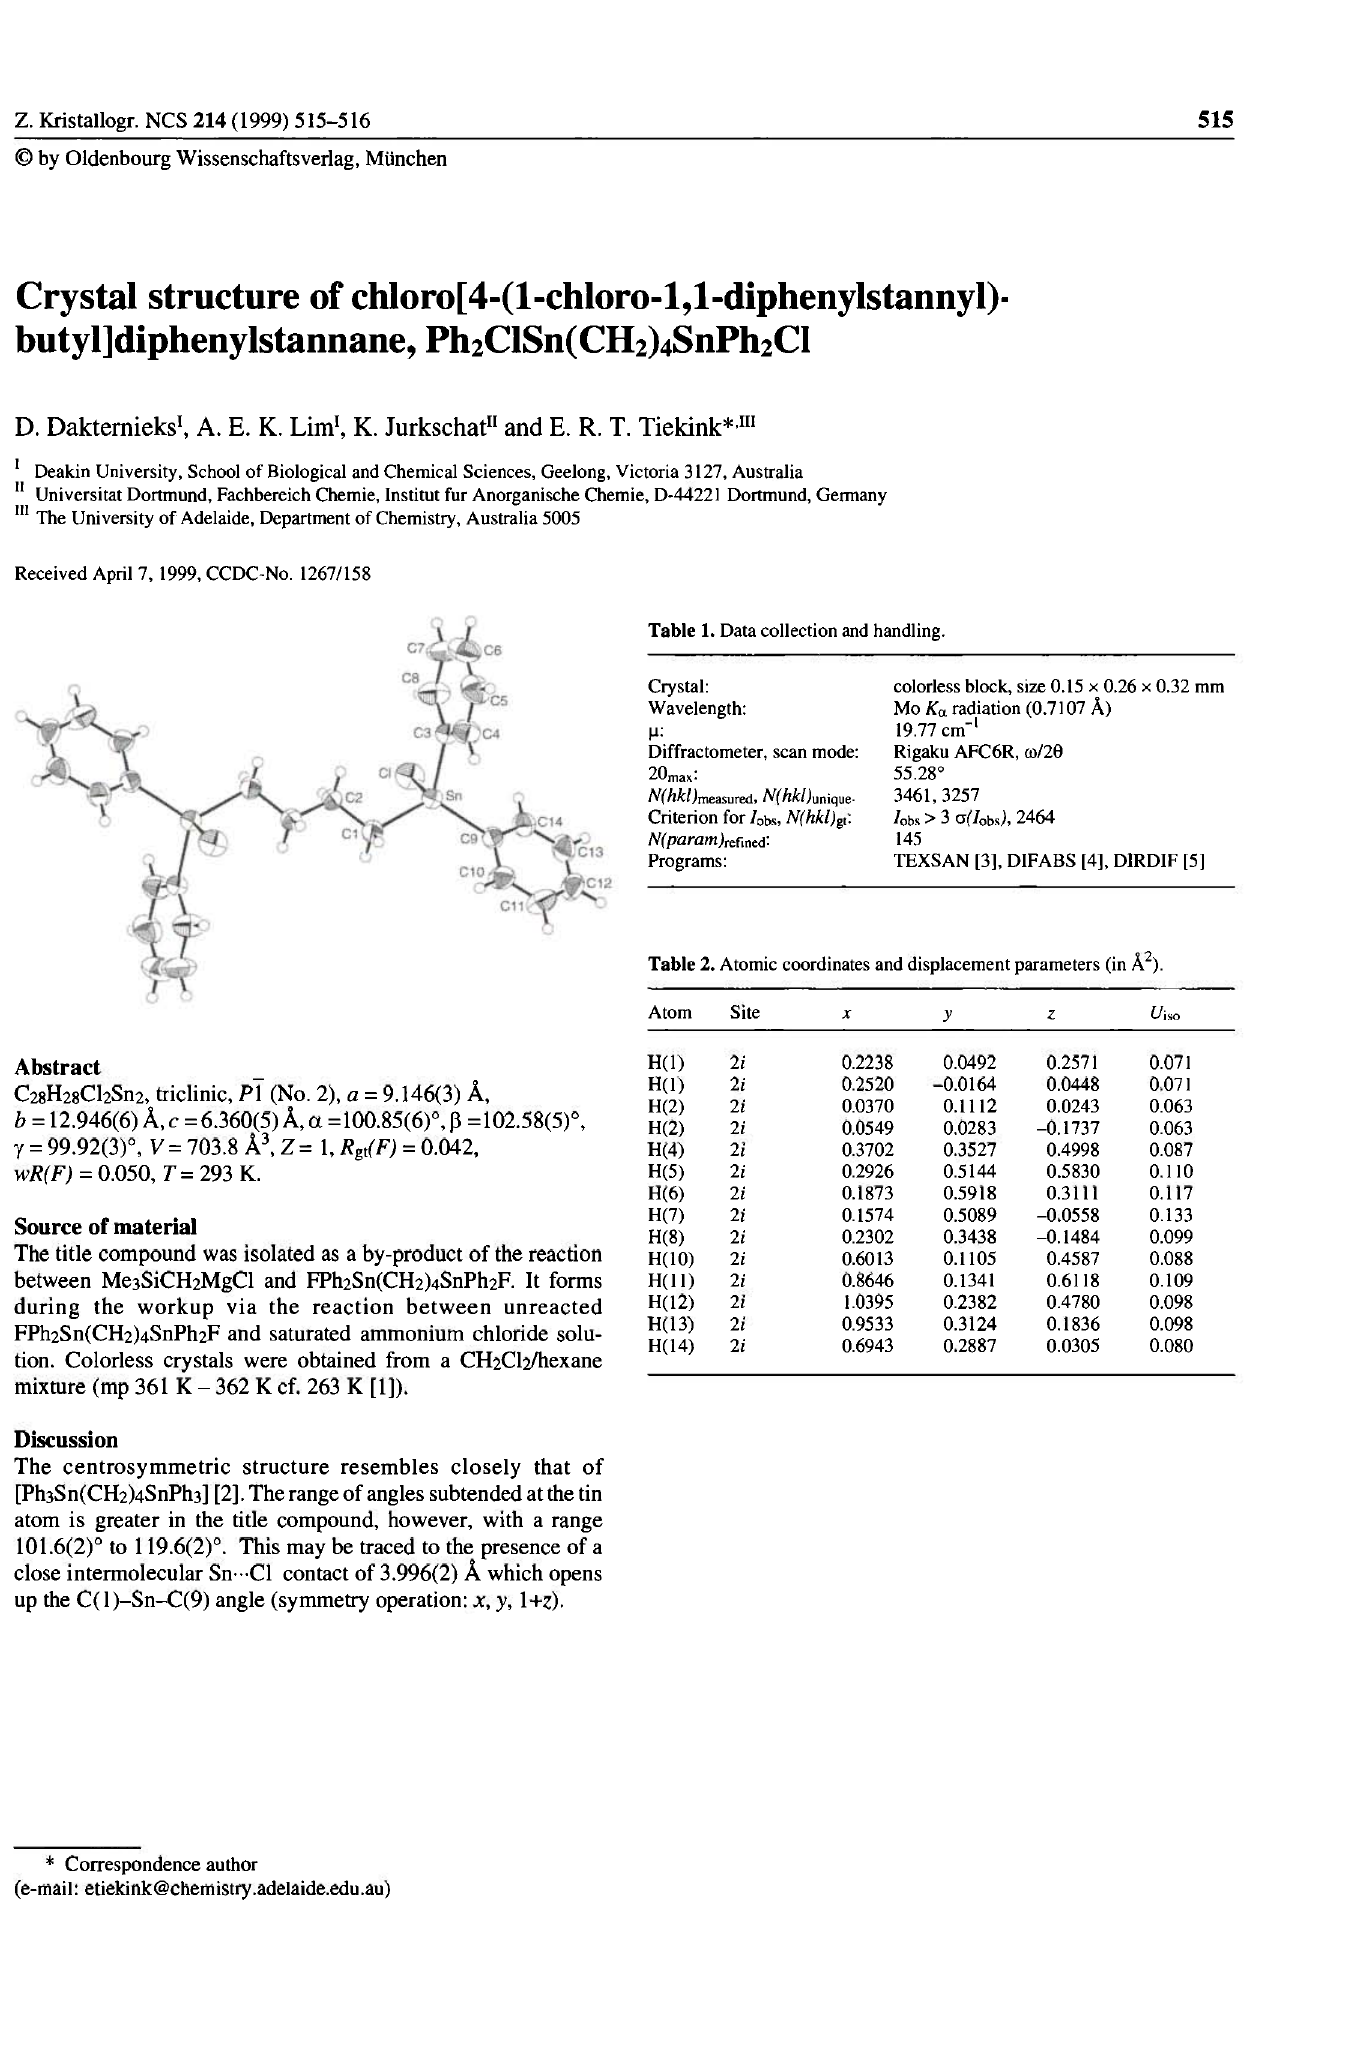
Table 1. Data collection and handling.